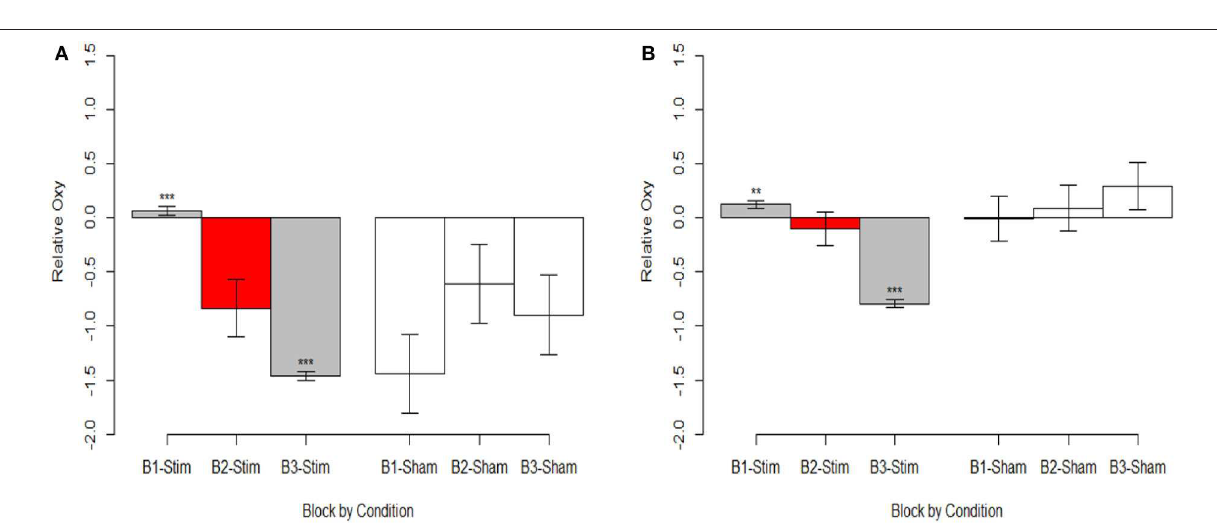
with the stimulation group as the comparison condition so we stimulation